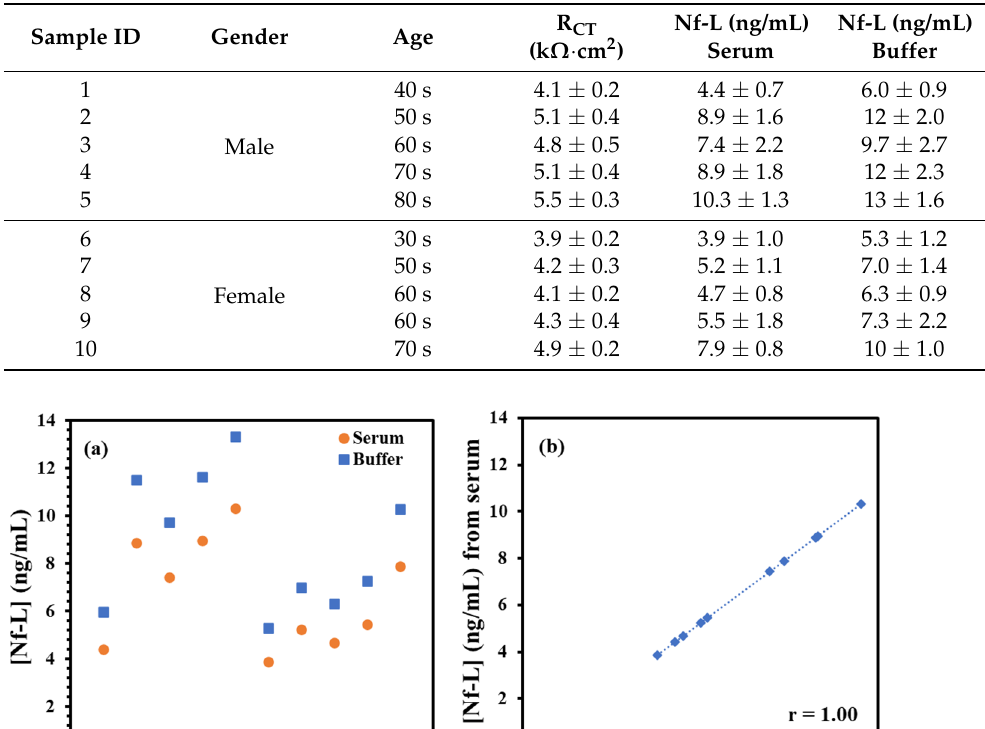
Table 1. Charge transfer resistance (R CT signals) of ALS serum samples and the concentration of Nf-L obtained in serum-based and PBS buffer-based calibration model. The data is divided into two groups based on gender and it represents varied ages. Actual concentration of Nf-L in the serum was calculated by multiplying the concertation obtained from the regression model with 10 × dilution factor. R CT and concentration values of each sample show standard error for n ≥ 3 replicates.